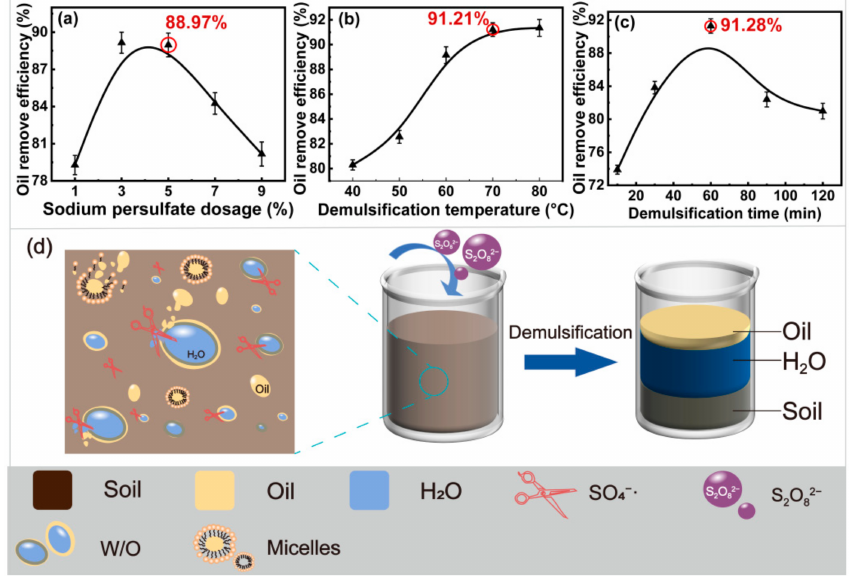
Figure 2. Effects of demulsification on oil removal efficiency in S/D treatment. (( a ), sodium persulfate dosage; ( b ), demulsification temperature; ( c ), demulsification time; ( d ), demulsification mechanism of sodium